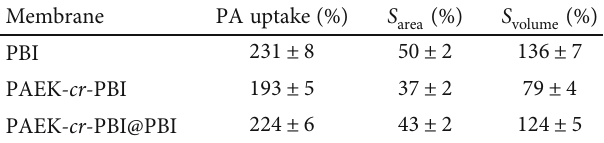
Table 1: PA doping behavior of the membranes. Membrane